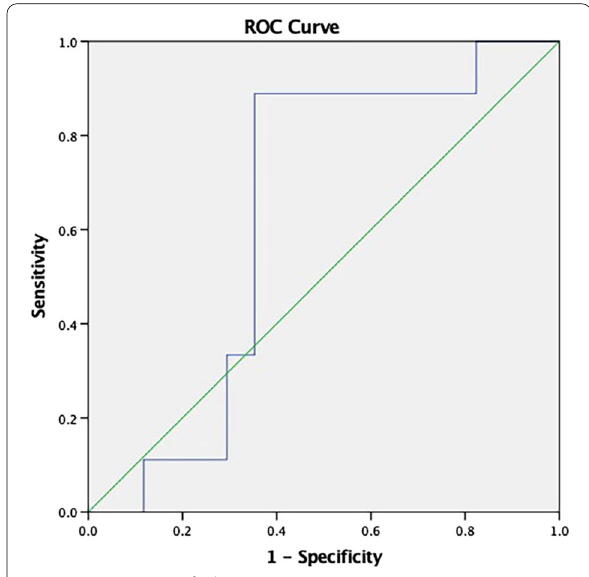
Fig. 10 ROC curve of wbTLG